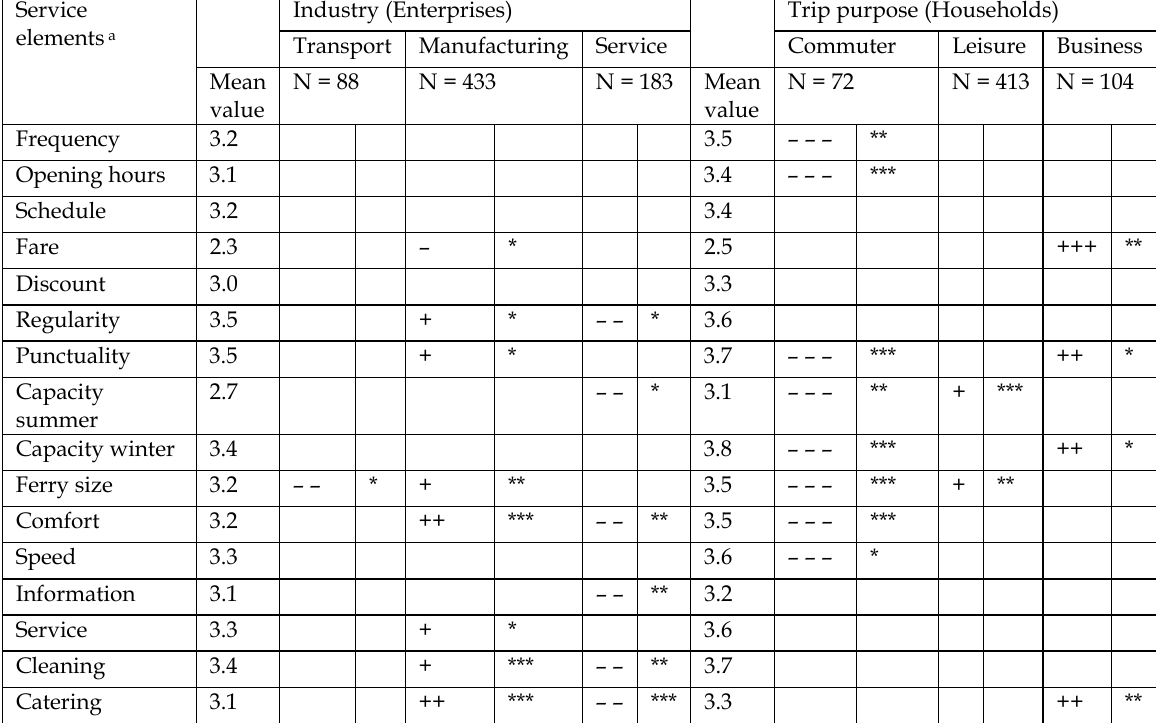
Table 5. Significant deviations in the assessment of satisfaction for different groups of